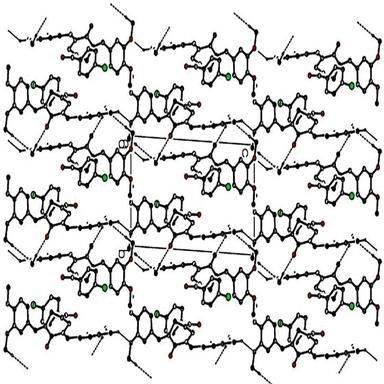
PACKING OF THE MOLECULES IN THE UNIT CELL WHERE THE DASHED LINES INVOLVE HYDROGEN ATOMS